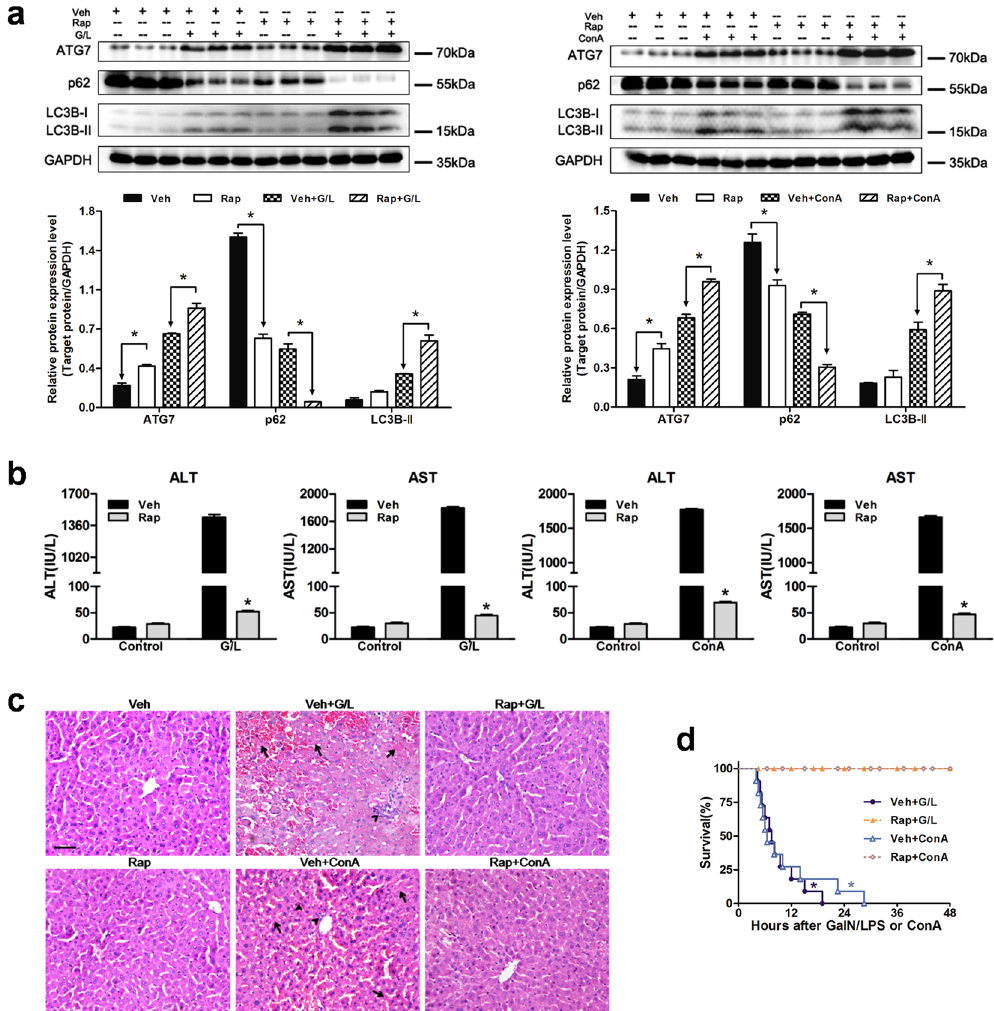
Figure 3. Autophagy induction by rapamycin attenuates ALF caused by GaIN/LPS or ConA in mice. Mice were pretreated with rapamycin (Rap, 2 mg/kg, 30 min, IP) prior to GaIN/LPS (G/L, 600 mg/kg /0.5 μ g/kg, 7 h, IP) or ConA (20 mg/kg, 6 h, IV) challenge. ( a ) Determination of ATG7, p62, and LC3B expression in the presence or absence of Rap. The data are shown as the means ± SEM. n = 4–6 per group. * P < 0.05 indicates significant differences. ( b ) Quantification of serum aminotransferase levels. The data are shown as the means ± SEM. n = 6 per group. * P < 0.05 vs. the corresponding vehicle (Veh) group. ( c ) H&E staining of mice livers. The arrows denote hepatocellular necrosis; the arrowheads denote infiltrating inflammatory cells. Original magnification × 400, scale bar 50 µ m. n = 4 per group. ( d ) Pretreatment with Rap increased survival rate of mice subjected to G/L or ConA challenge. n = 10–11 per group. * P < 0.05 compared to the Rap-treated